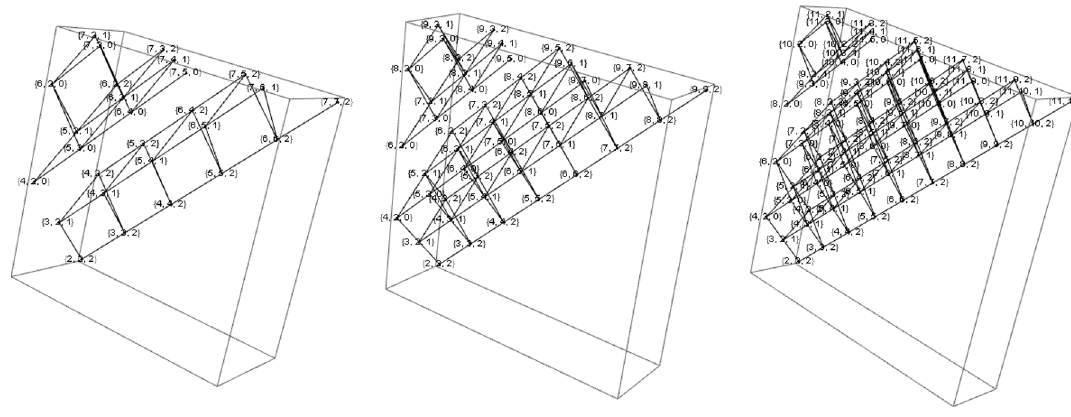
ˆ Figure 5. K actions on zero-form fields in 4 , 6 , 8 dimensions are depicted as the edges of graph.